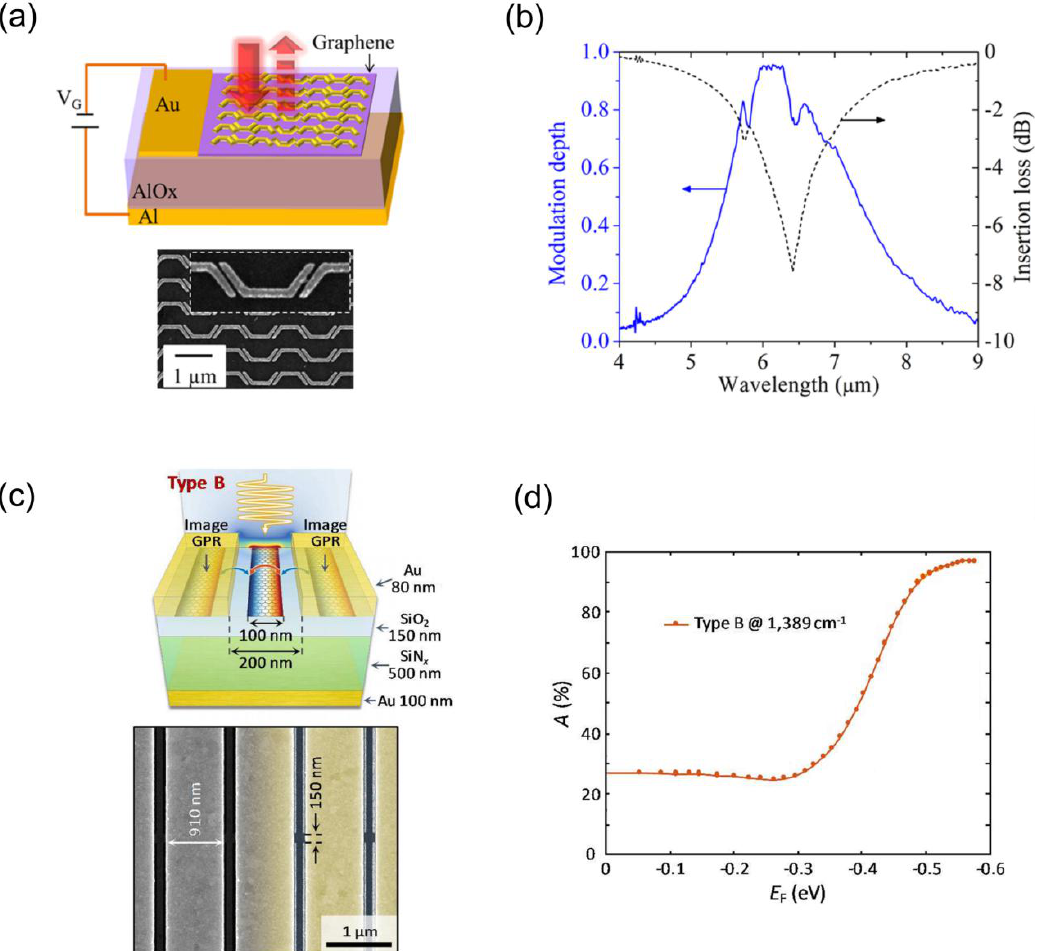
Figure 9 Figure 9. ( a ) Top: schematic of the ultrathin optical modulator based on a tunable metasurface absorber. Bottom: a SEM image of the metasurface on graphene. Inset: a zoomed-in view of a portion of the metasurface. ( b ) The modulation depth achieved experimentally at different wavelength and corresponding insertion loss for the structure shown in ( a ) [72]. ( c ) Top: schematic of a perfect absorption structure incorporating graphene plasmonic ribbons and plasmonic metallic antennas. Bottom: a SEM image of the top structure. ( d ) Absorption of the structure shown in ( c ) as a function of graphene Fermi level ( E F ) at the frequency for maximum absorption [73]. Reproduced from references [72,73], with permission from American Chemical Society, 2014; with permission from American Chemical Society,